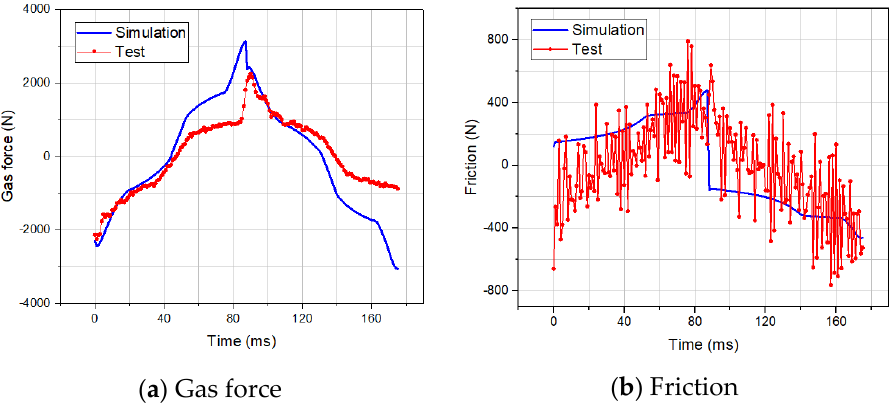
Figure 9. Comparison of test result and simulation result.